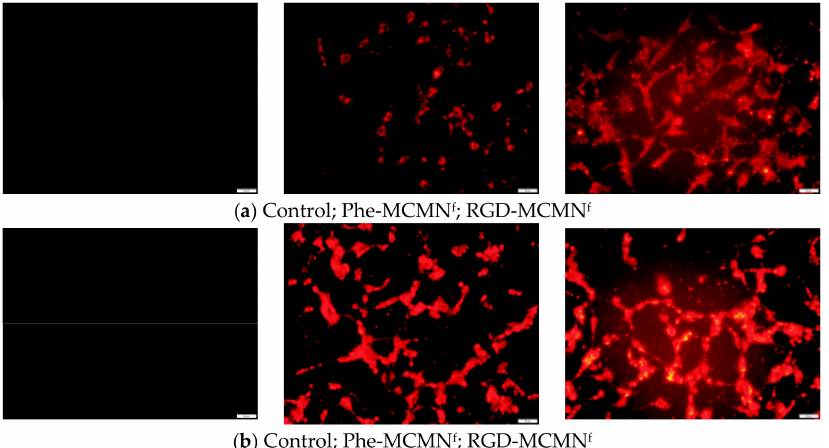
Figure 2. MCF-7 ( a ) and U87MG ( b ) cells were seeded at densities of 6.0 × 10 3 and 20.0 × 10 3 cells per well, respectively. Confocal microscopy analysis of cellular uptake after 24 h of treatment using the fluorescent-labeled nanoformulations (Phe-MCMN f and RGD-MCMN f ) at 5.15 × 10 − 3 µ mol · L − 1 of well). Photomicrographies were obtained at 20 × magnification with an Olympus IX71 fluorescent microscope (Olympus Corporation, Tokyo, Japan) (bar = 100 µ